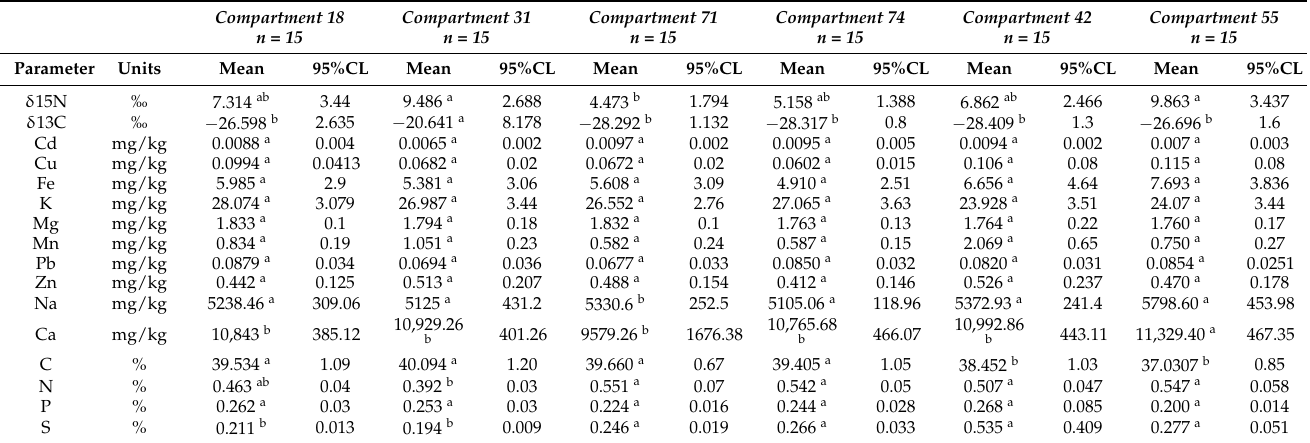
Table 2. The chemical composition of Rhizophora apiculata roots in six compartments (18, 31, 71, 74, 42, and 55).